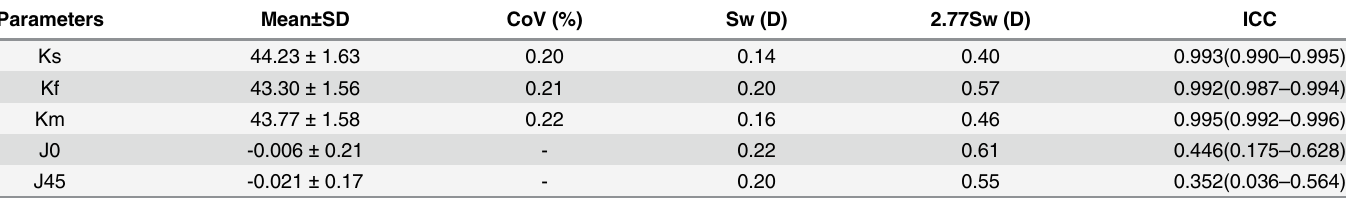
Table 2. The interobserver reproducibility of Ks, Kf, Km, J0 and J45 obtained by Topcon KR-1W. (Note: D: diopter, SD: standard deviation, Sw: within- subject standard deviation, CoV: within-subject coefficient of variation, ICC: intraclass correlation coefficient.)